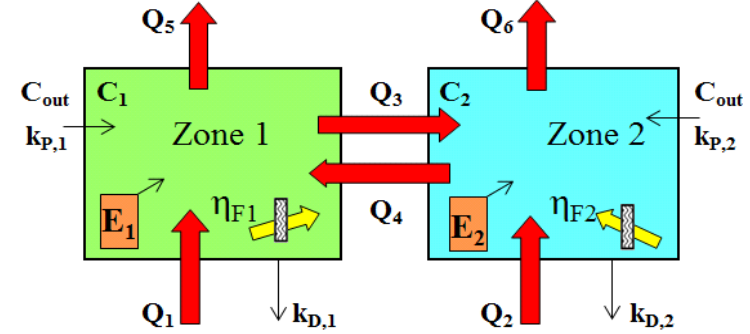
Figure 1. Configuration of the well mixed two-zone model, also, schematic of the two zone IAQ model, showing flows Q (mg·m − 3 ); emission rates E (dimensionless); deposition loss rates k and η η F1 F2